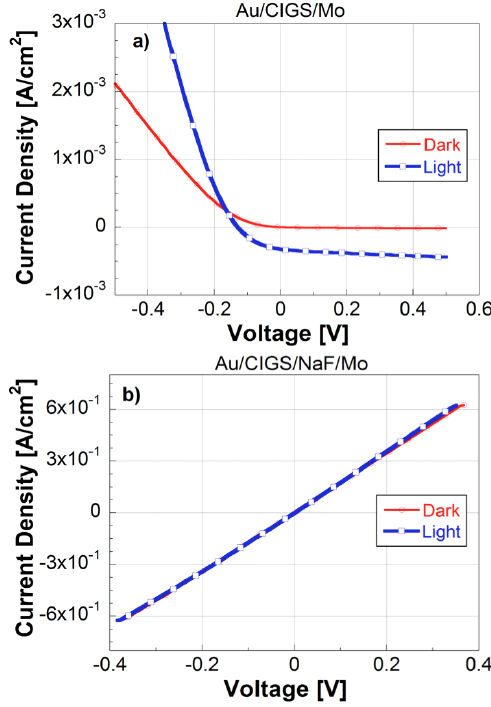
Figure 4. IV characteristics in the dark (red curves) and under illumination (blue curves) of the ( a ) Au/CIGS/Mo and ( b ) Au/CIGS/NaF/Mo structures deposited on a glass substrate. The curves clearly indicate the CIGS/Mo contacts to be rectifying and ohmic in the sample without and with NaF, respectively.